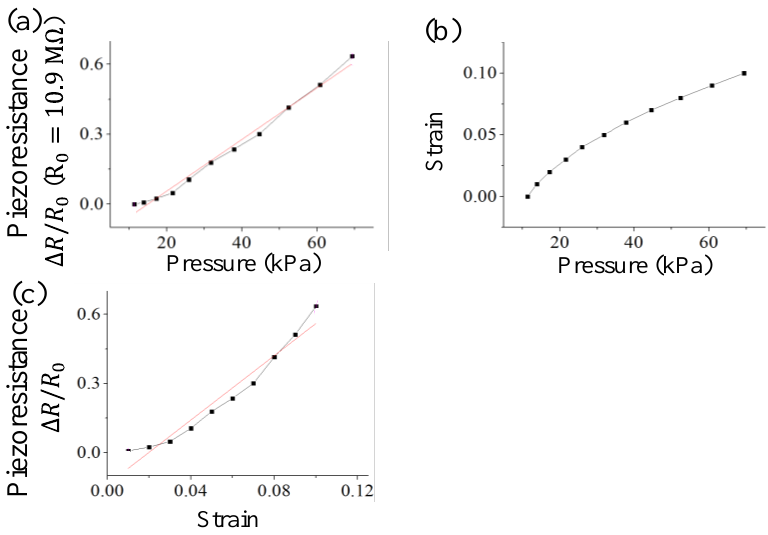
Figure 8. Piezoresistance and strain of CPDMS under different pressure. ( a ) Piezoresistance to pressure; ( b ) Strain to pressure; ( c ) Piezoresistance to strain. The black lines are the measurement results and the red lines are the linear approximation of the measurement results.